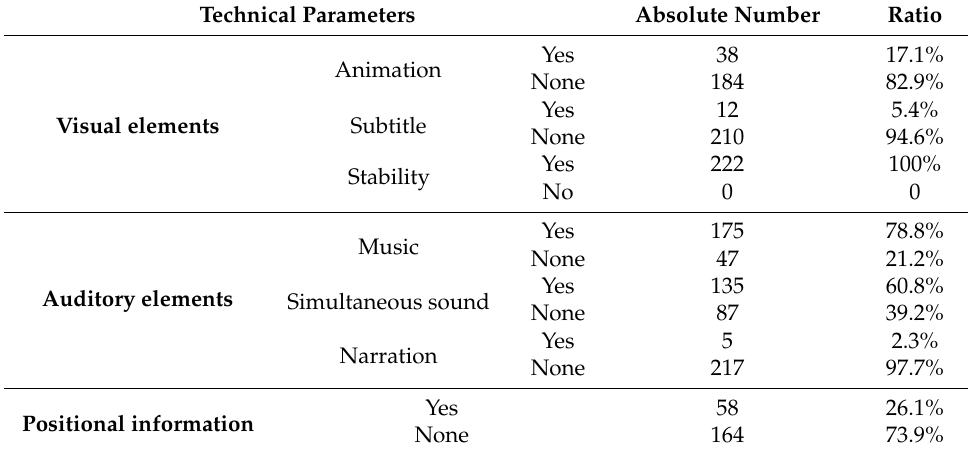
Table 1. Analysis of the basic characteristics of the sample